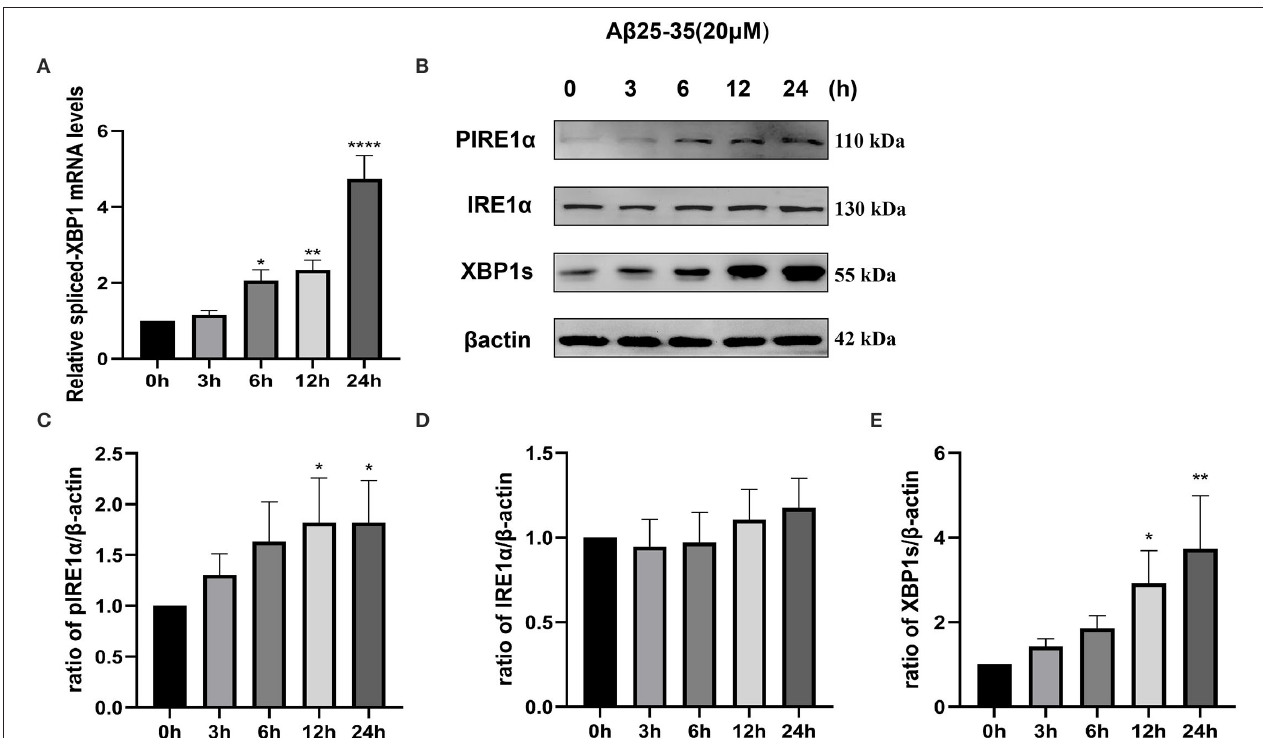
FIGURE 1 | Activation of the IRE1 signaling pathway in A β -treated SH-SY5Y cells. Cells were treated with 20 µ M A β 25–35 for 0, 3, 6, 12, and 24h. (A) Quantitative real-time PCR (qRT-PCR) analysis of spliced- XBP1 mRNA levels. Data were expressed as the fold-change compared with β -actin mRNA levels. (B) Western blot analysis of pIRE1 α , IRE1 α , and XBP1s proteins. (C–E) Densitometric analysis of pIRE1 α , IRE1 α , and XBP1s protein levels normalized to the β -actin level. The data are presented as mean ± SD ( n = 3), * P < 0.05 compared with the control. ** P < 0.01 compared with the control. **** P < 0.0001 compared with the